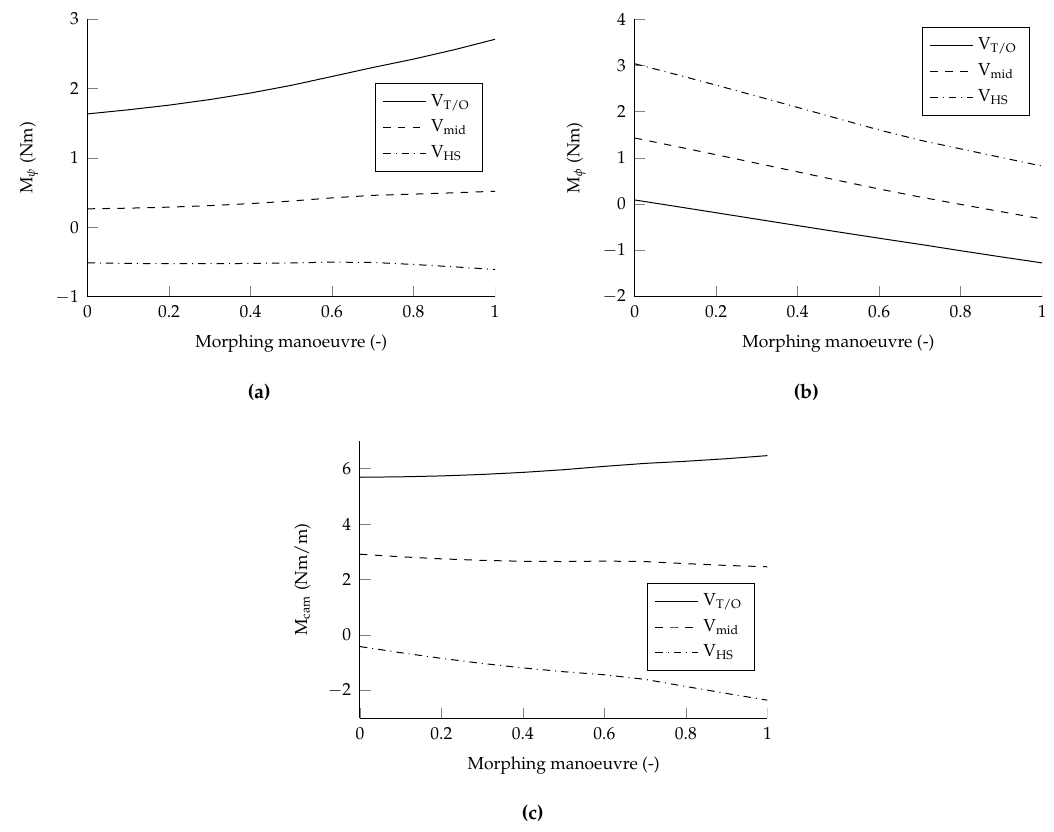
Figure 3. Effect of flight conditions on morphing actuator requirements. ( a ) Shear morphing moment of shear section 1; ( b ) Twist morphing moment; ( c ) Leading edge camber morphing moment at the wing